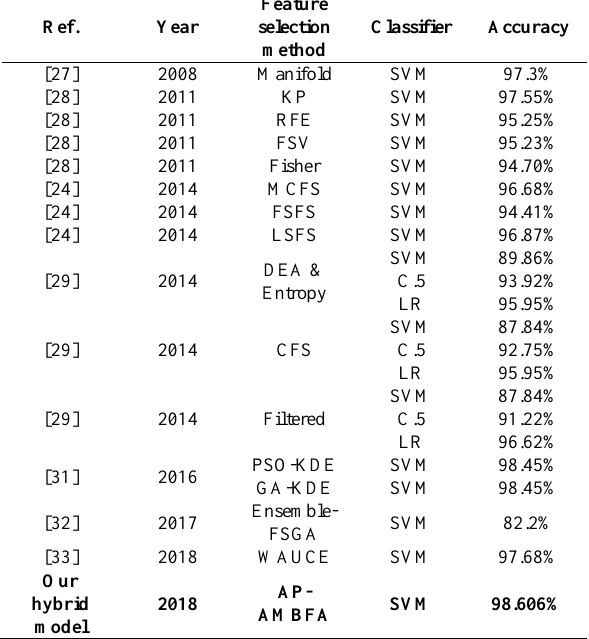
Table 4. Comparison results between our hybrid model and previous models on WDBC dataset.